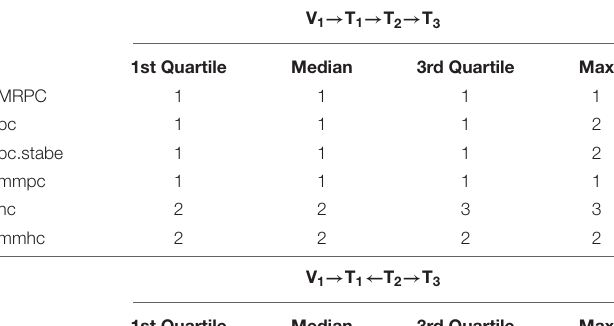
TABLE 3 | Summary statistics of the counts of uniquely inferred graphs with node permutation.